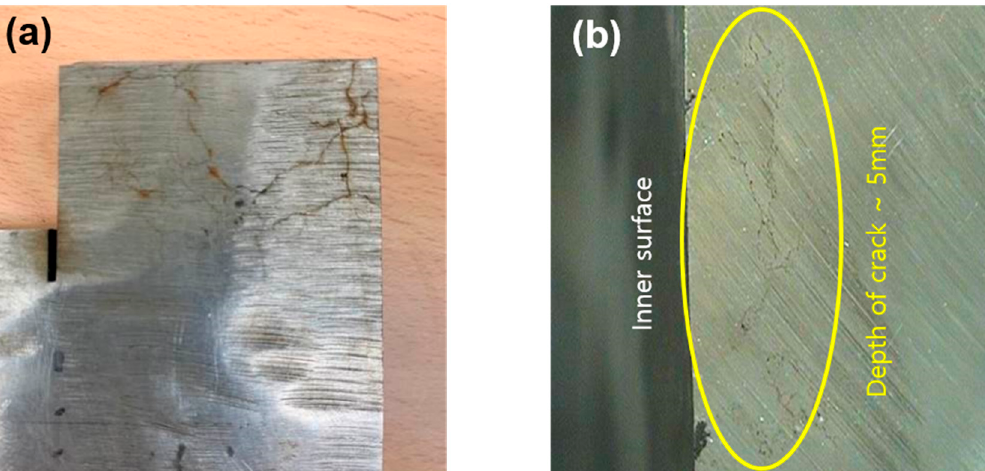
Figure 2. ( a ) Photographs of the cutoff sample and ( b ) photographs of the cross section of the cutoff sample. Depth of the crack from the inner surface was approximately 5 mm, 1